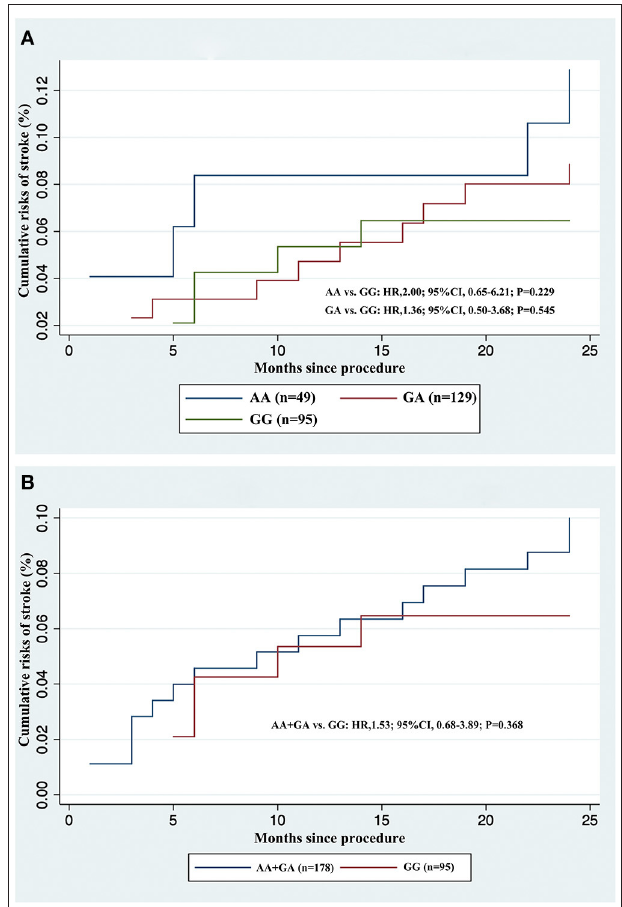
FIGURE 3 | Cumulative incidences of recurrent stroke in acute minor ischemic stroke and transient ischemic attack patients treated with dual antiplatelet therapy, stratified by rs12041331 genotypes. (A) AA or GA carriers vs. GG wild type. (B) AA + GA carriers vs. GG wild